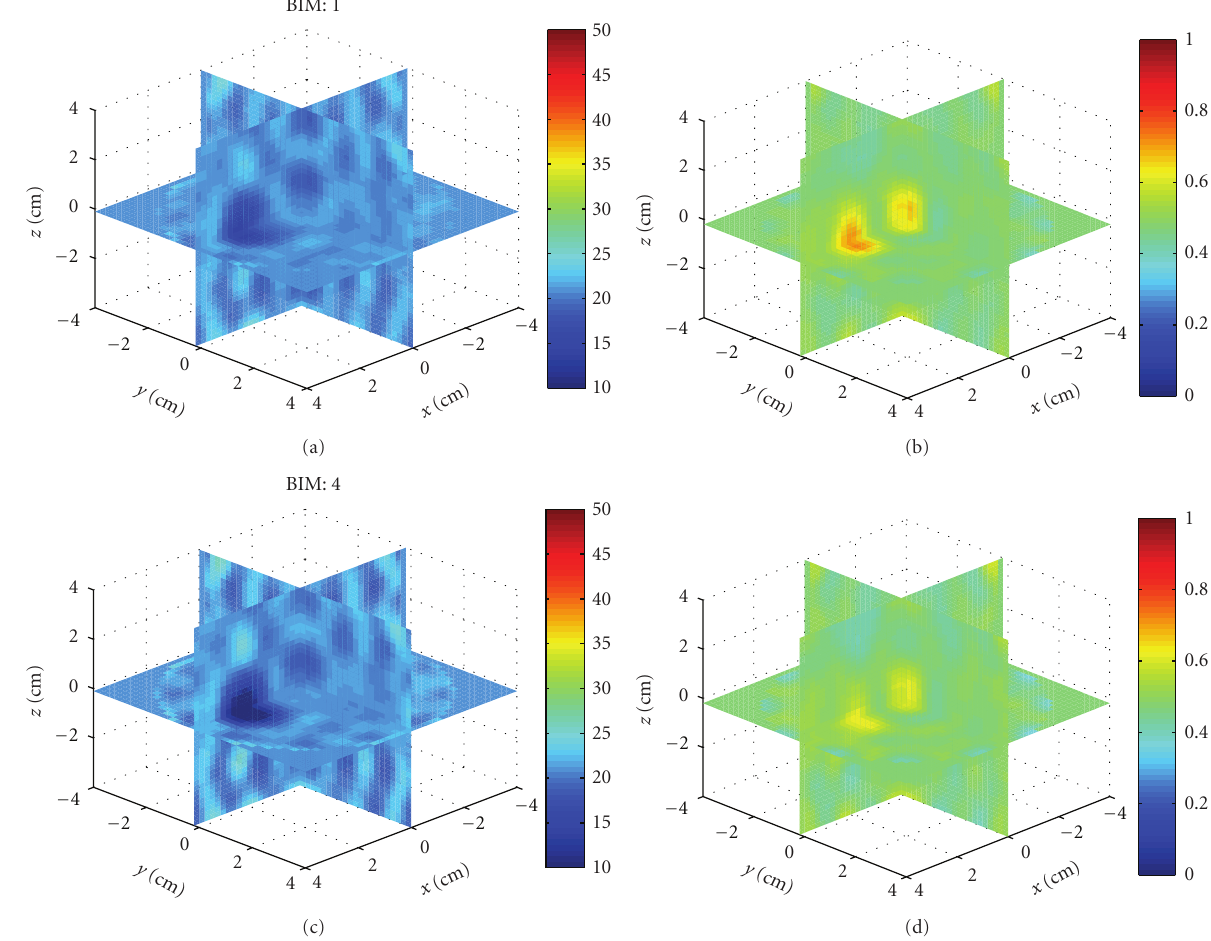
Figure 12: Reconstructions of a single sphere ( (cid:2) r , σ ) = (10, 1) located at ( x , y , z ) = (0,0,2 cm) of Example 1. Born iterations helped the recovery of the low permittivity in (c), but at the expense of the correct conductivity value which was better with the Born approximation in